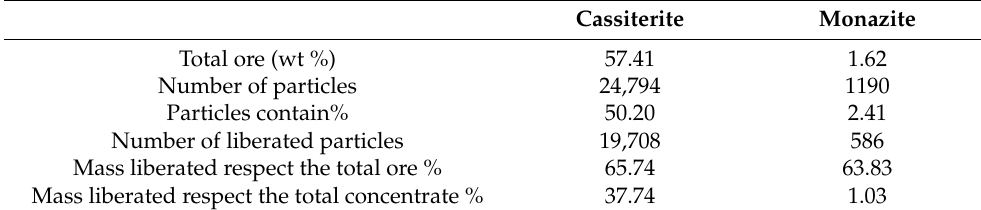
Table 4. Characteristics of ore-bearing particles from concentrate 2 of the C-4 plant.